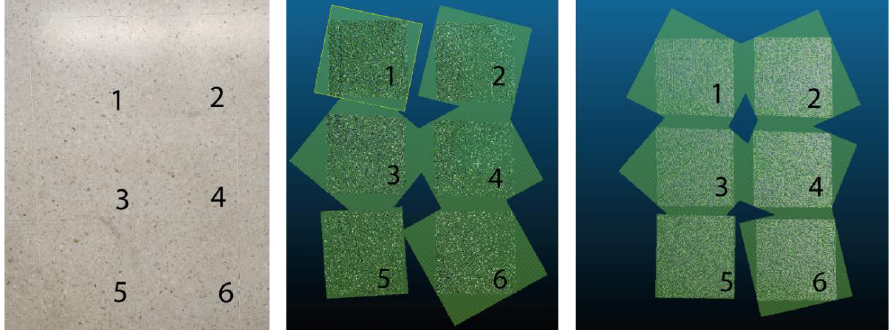
Figure 2. Standard deviation measurements: tiles (left), LiVOX Avia point cloud and plane fitting (center) and Faro Focus 3D point cloud and plane fitting (right).